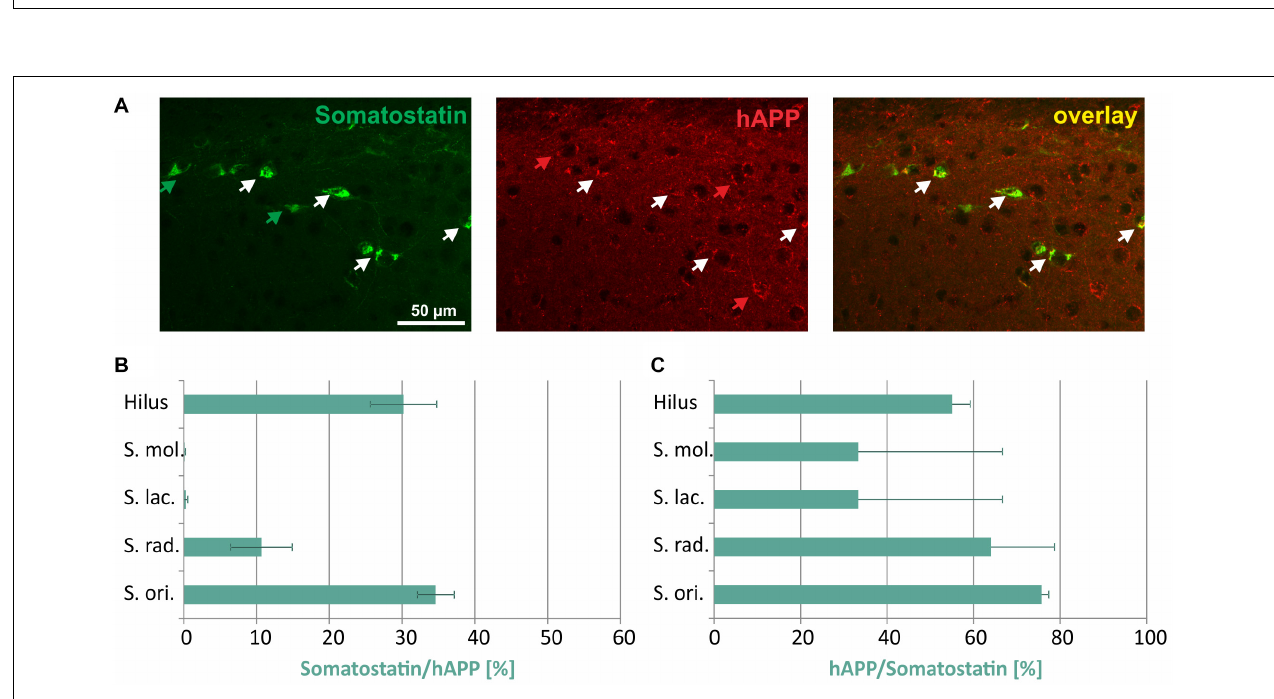
FIGURE 5 | Quantitative analyses of the co-localization between somatostatin-immunoreactive neurons and hAPP-expressing interneurons in hippocampus of Tg2576 mice. Typical examples of double labelings in stratum oriens are shown in panel (A) . White arrows point to double-labeled neurons, green, and red arrows to neurons that are only labeled by green (somatostatin) and red (hAPP) fluorescence, respectively. Quantitative analysis revealed that of all hAPP transgene-expressing interneurons 1 to 2% in stratum moleculare and stratum lacunosum moleculare to approximately 30% (in DG hilus and stratum oriens ) were somatostatin- immunoreactive (B) . Of all somatostatin-expressing neurons, 30 to 76% expressed the hAPP transgene in all hippocampal layers (C) .